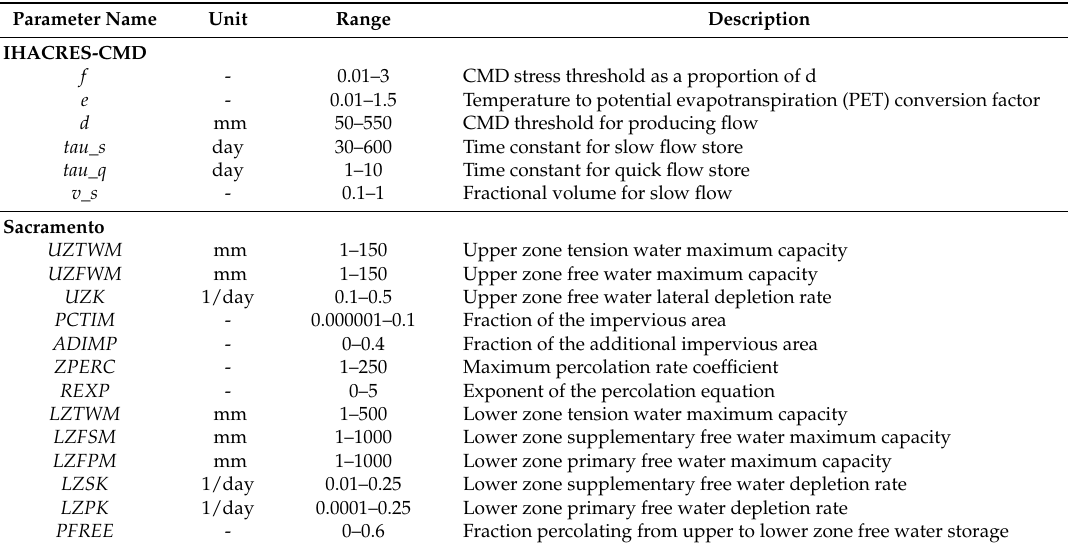
Table 1. Parameters for each model.